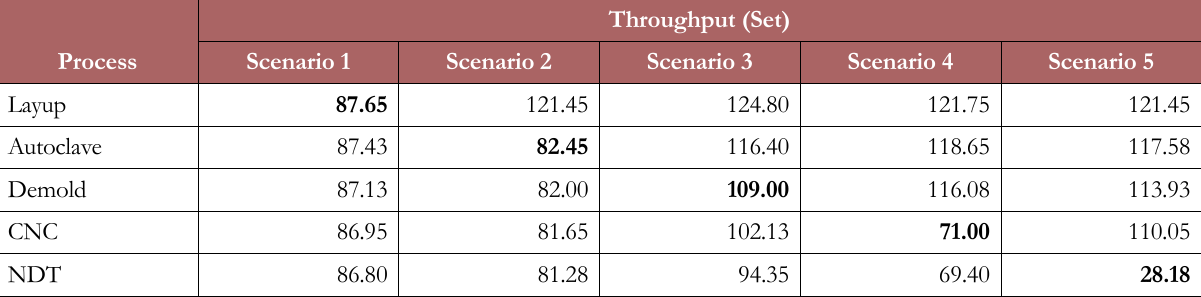
Table 7. Throughput at each process after the arrival rate is